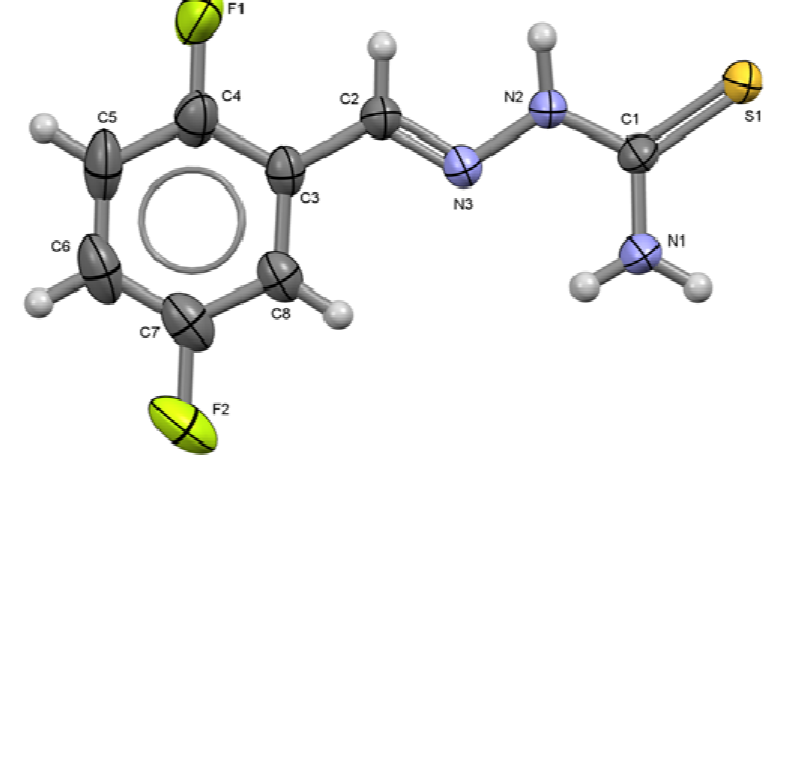
Figure 2. ORTEP drawing of 2,5-C shown at 50% of probability. Selected bond lengths (Å) and angles (°): S1-C1 1.6881(15), C1-N1 1.3182(19), C1-N2 1.3438(18), N2-N3 1.3752(17), N3-C2 1.2699(19) C2-C3 1.462(2) C4-F1 1.355(2), C7-F2 1.356(2); S1-C1-N1 123.45(12), S1-C1-N2 119.04(11), N1-C1-N2 117.51(14), N2-N3-C2 115.50(13), N3-C2-C3